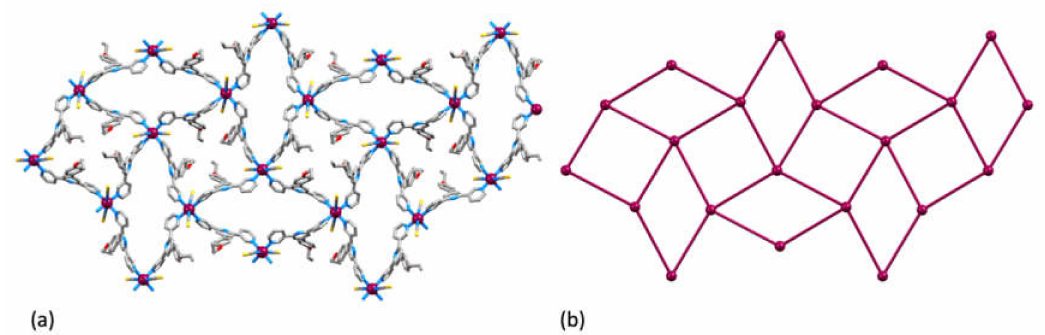
Figure 4. ( a ) Part of one (4,4) net (viewed down the crystallographic c -axis) in [{Co( 4 ) 2 (NCS) 2 } . 4CHCl 3 ] n ; H atoms and solvent molecules are omitted. ( b ) The same net defined by lines connecting the Co atoms.